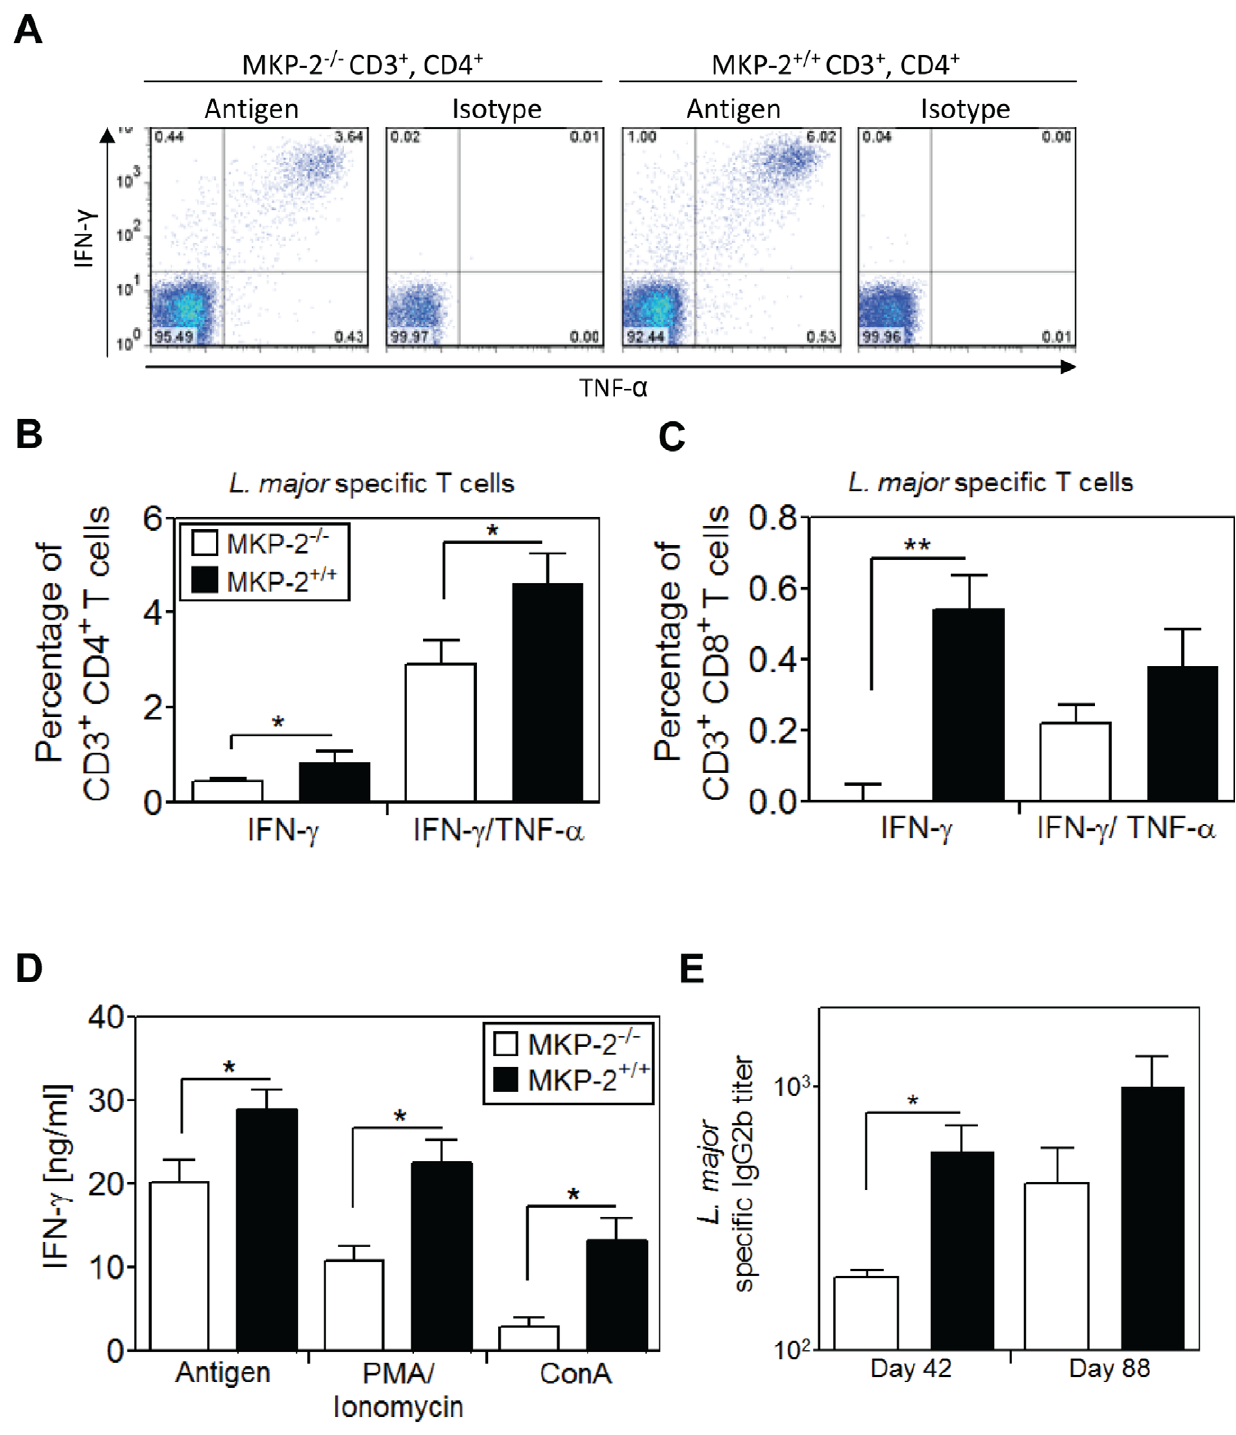
Figure 3. MKP-2 deficient mice infected with L.major have a reduced T H 1 response. Splenocytes from L. major infected MKP-2 2 / 2 (open columns) and MKP-2 + / + (closed columns) mice were re-stimulated either with antigen pulsed DC, PMA/Ionomycin, ConA or with unpulsed DC (Medium control) for 6 h (FACS) or 48 h (ELISA). Cells were stained for T cell surface markers CD3, CD4 and CD8 as well as intracellular cytokines IFN- c and TNF- a or their respective isotypes (A). Percentages of IFN- c single and IFN- c /TNF- a double producing parasite-specific CD4 + (B) and CD8 + (C) T cells are shown after normalization to medium and isotype controls. Supernatants of 48 h T cell re-stimulations were analyzed for IFN- c in a sandwich ELISA and values were normalized to medium controls (D). Serum of infected mice was collected and analysed for parasite-specific antibody isotype IgG2b. The titres were calculated as reciprocal dilution of the half-maximal absorption at 450 nm (E). Error bars are shown as standard error of the mean (SEM). * P , 0.05, ** P , 0.01; one-tailed Mann Whitney U test. The data shown is representative of two independent experiments.